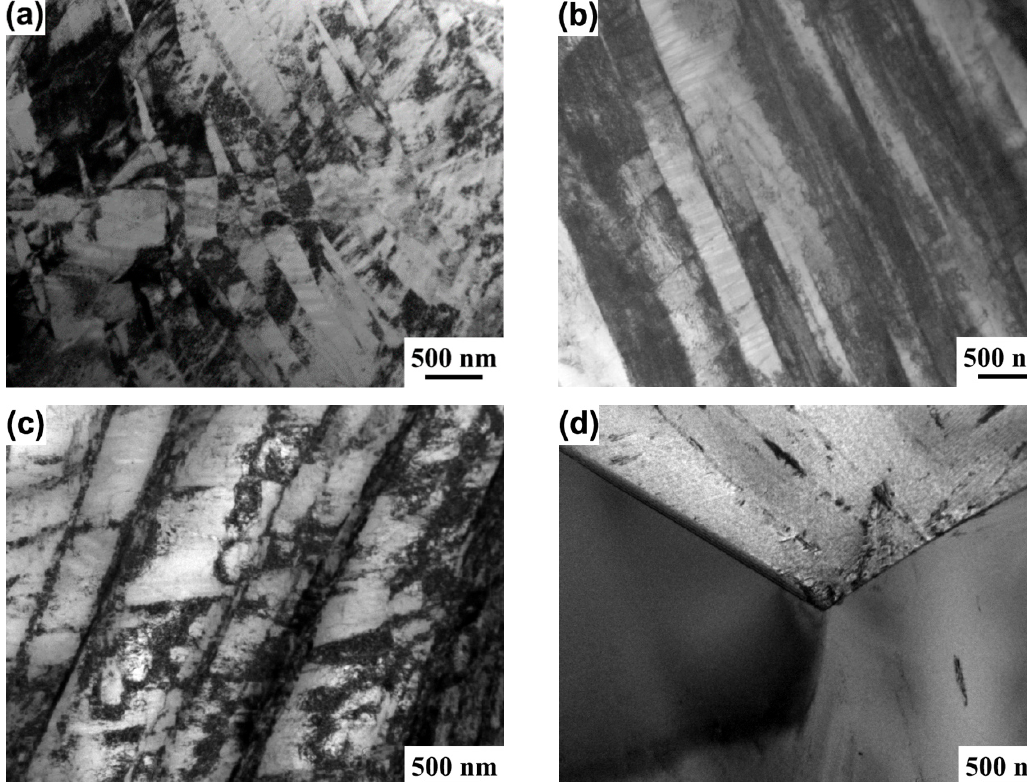
Figure 4. Cross-sectional TEM images of the specimens treated by different charging voltages: 2 kV ( a ), 4 kV ( b ), 6 kV ( c ), and 8 kV ( d ).